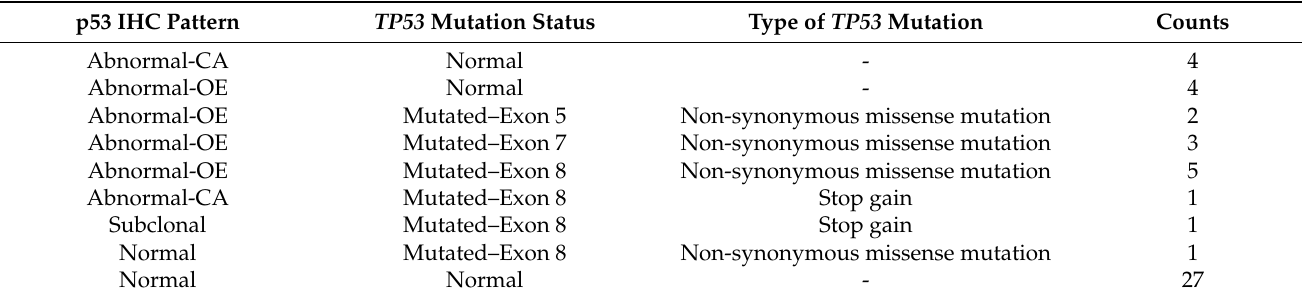
Table 6. Comparison between p53 IHC pattern and TP53 mutation status ( n =